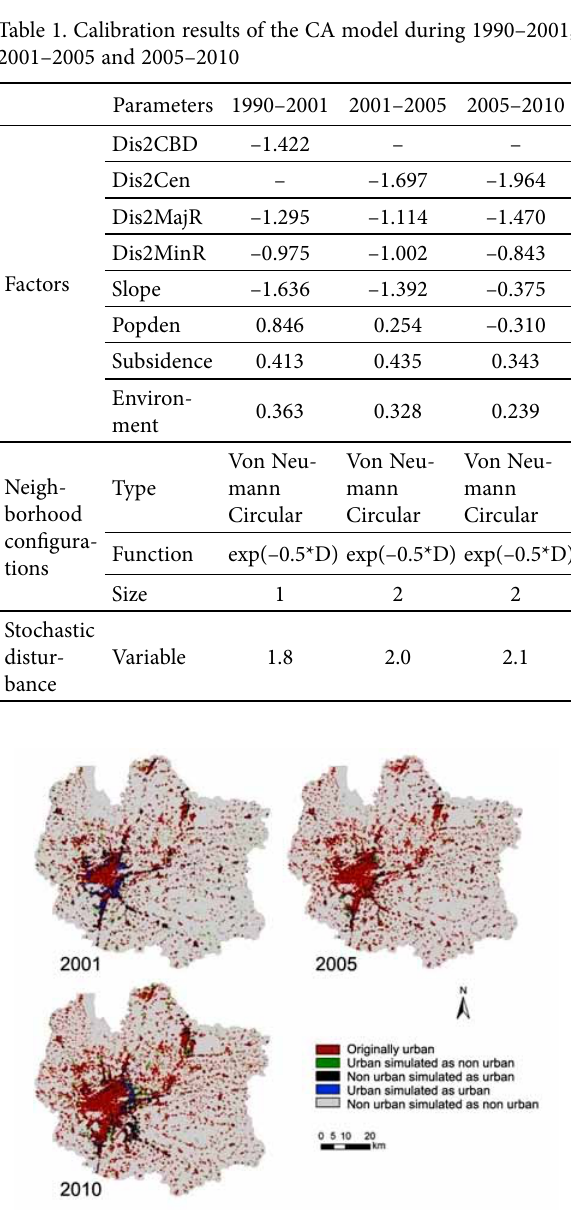
Fig. 7. Spatial distribution of corrects and errors of the simulation